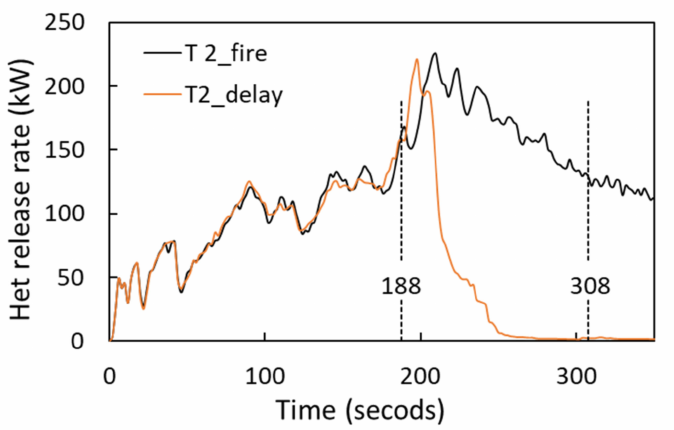
Figure 10. Heat release rate for simulation T2_delay.